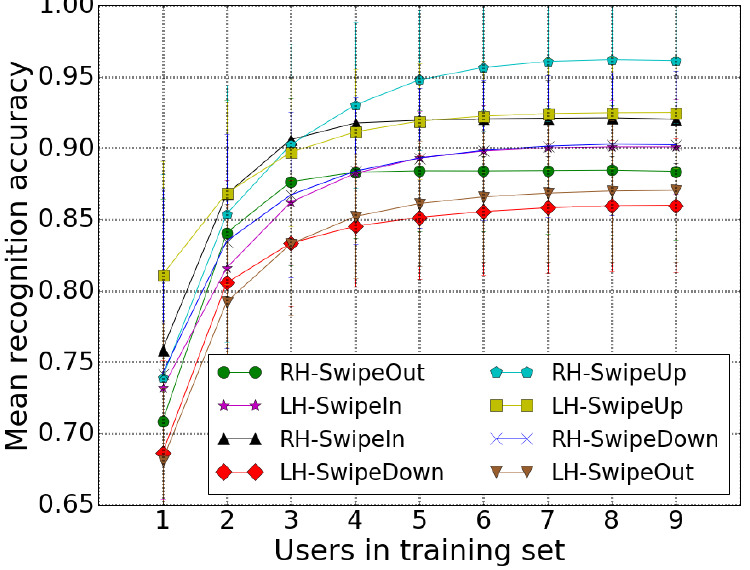
Figure 5. Mean accuracy per gesture vs. number of users in training set, with the mischievous